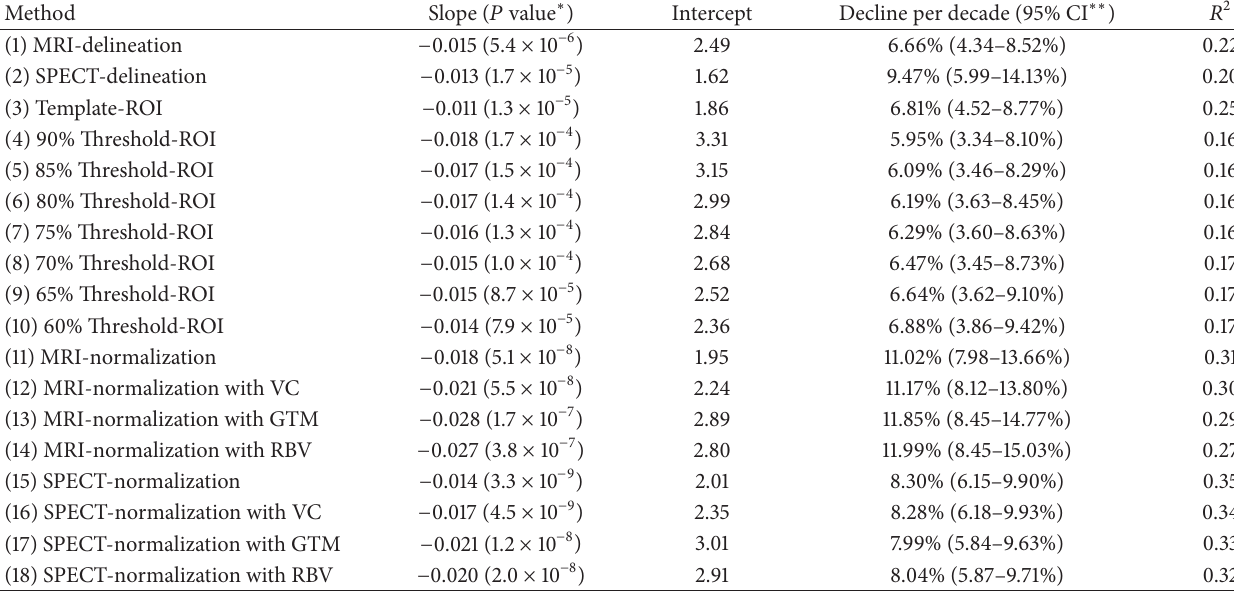
Table 2: Comparison of the regression lines between quantification methods of measuring DAT availabilities. Method Slope ( 𝑃 value ∗